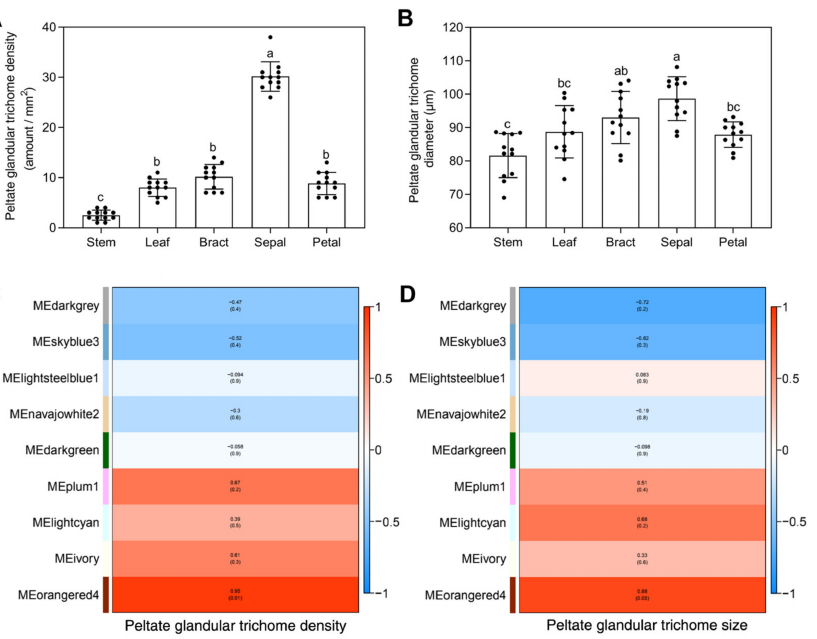
Figure 6. Modular organization analysis of gene expression in different tissues of Origanum vulgare ‘Hot and Spicy’ related to peltate glandular trichomes (PGTs). The density of PGTs in different tissues ( A ). The diameter of PGTs in different tissues ( B ). Different letters indicate significant differences ( p < 0.05). Module–PGT density correlations and corresponding p -values ( C ). Module–PGT size correlations and corresponding p -values ( D